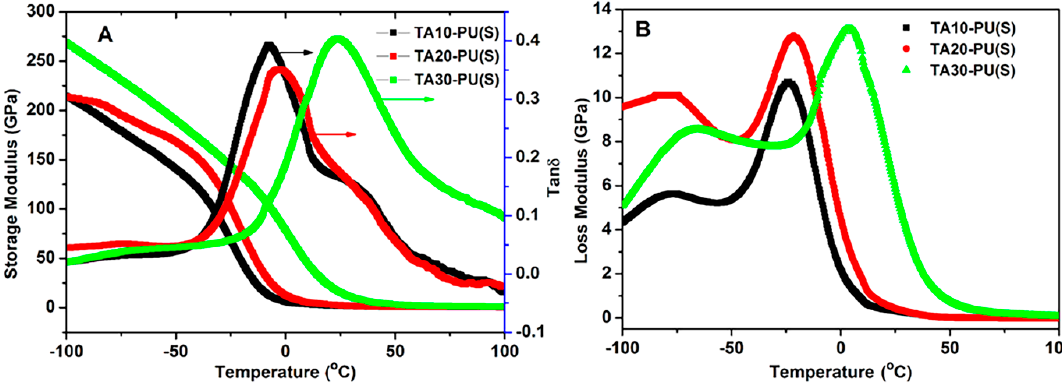
Figure 8. Temperature dependence of the storage modulus, tan δ ( A ) and loss modulus ( B ) of TA10(S)–PU, TA20(S)–PU, and TA30(S)–PU gels.